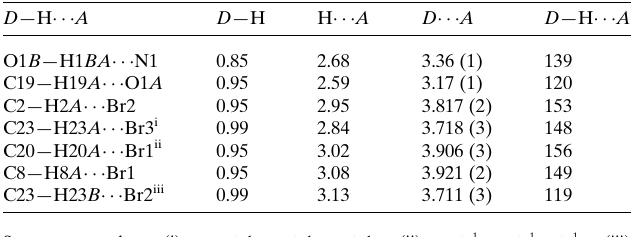
Table 1 Hydrogen-bond geometry (A˚ , (cid:5) ).